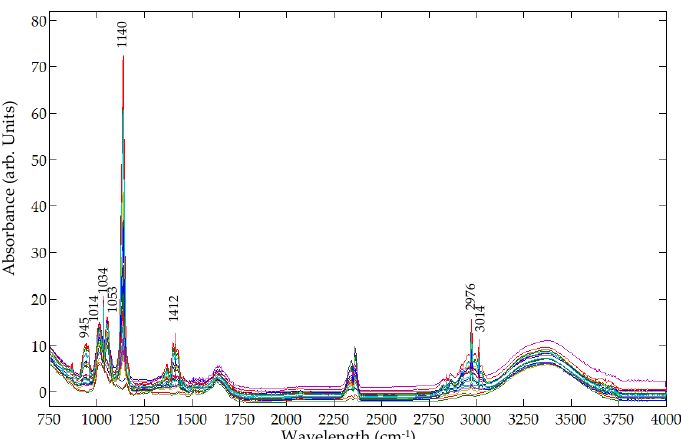
Figure 7. Original FT-IR spectra of mixture samples for all concentration levels.